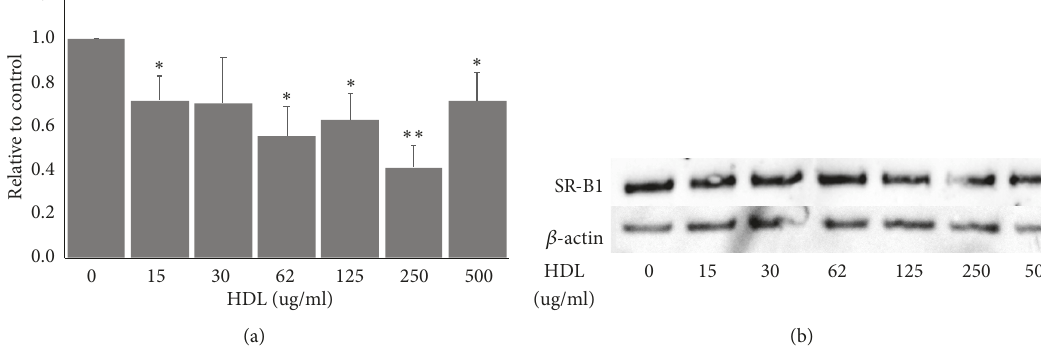
Figure1: Treatmentwithhighdensitylipoprotein(HDL)reducesscavengerreceptorclassBtype1(SR-B1)expressioninHepG2cells. (a)Treatment with15,62,125,250,and500ug/mlHDLallsignificantlyreducedproteinlevelsofSR-B1.(b)RepresentativeWesternblotshowingreductionof SR-B1 levels. Cells were treated with 15–500 ug/ml HDL for 24 hours. Cell lysates were collected and run on 4-12% Bis-Tris gels, transferred to nitrocellulose, probed with anti-SRB1 (1:750) and anti- 𝛽 -Actin (1:2000) antibodies, and developed using enzyme linked chemiluminescence. Protein levels were quantitated using ImageJ software ( ∗∗ p < 0.01, ∗ p < 0.05; 15-125 ug/ml, n=4 and 250-500 ug/ml,